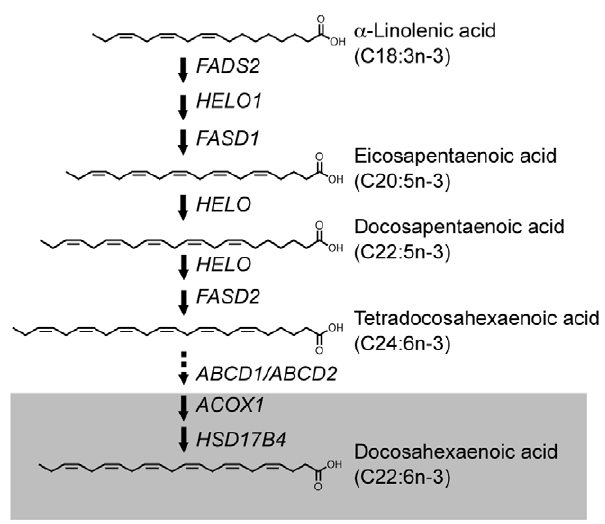
Figure 1. Overview of docosahexaenoic acid biosynthesis in liver. Diet-derived a -linolenic acid (C18:3n-3) is transformed into tetracosahexaenoic acid (C24:6n-3) by the sequential action of D 6 and D 5 desaturases (encoded by the FADS2 and FADS1 genes, respectively) and elongases (such as that encoded by the HELO1 gene) present in the endoplasmatic reticulum. Tetracosahexaenoic acid is transported into peroxisomes (shaded area), presumably by proteins encoded by the ABCD1 or ABCD2 genes, and then converted into docosahexaenoic acid (C22:6n-3) by sequential action of acyl coenzyme-A oxidase (encoded by the ACOX1 gene), D -bifunctional protein (encoded by the HSD17B4 gene), and various peroxisomal thiolases (not shown). The figure shows chemical structures of fatty acids quantified in our analyses.